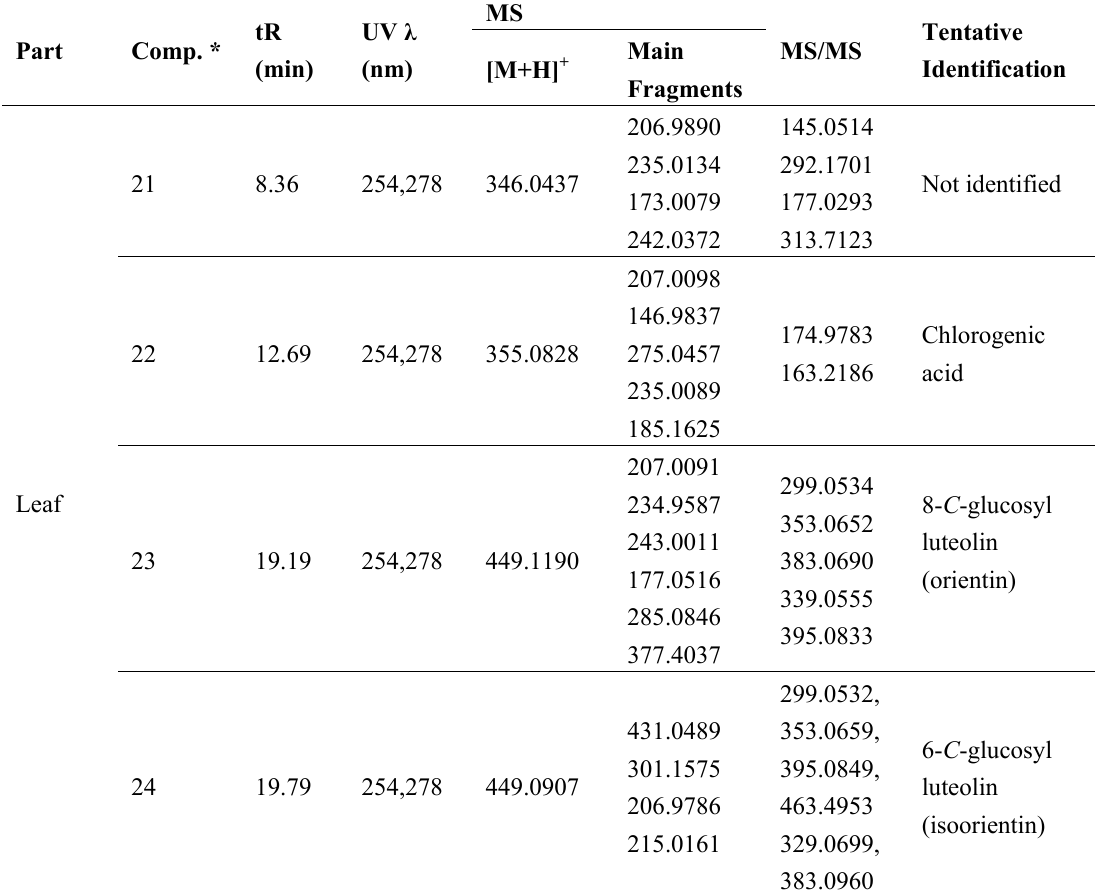
Table 6. Partial characterization of water extracts of different parts of bamboo by